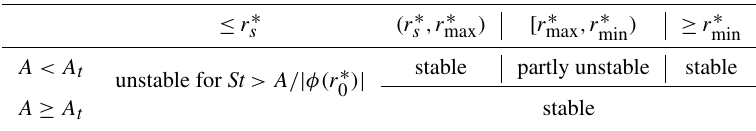
and r ∗ max are defined in the text body. min